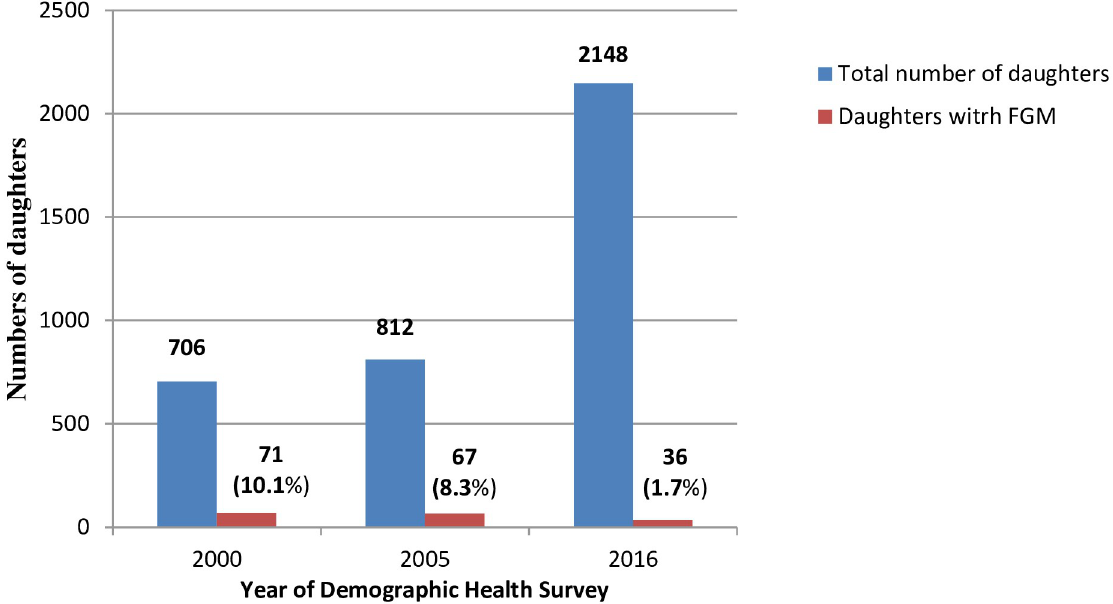
Fig 3. Female genital mutilation (FGM) in daughters born to mothers who did not have FGM in Ethiopia in 2000, 2005 and 2016.